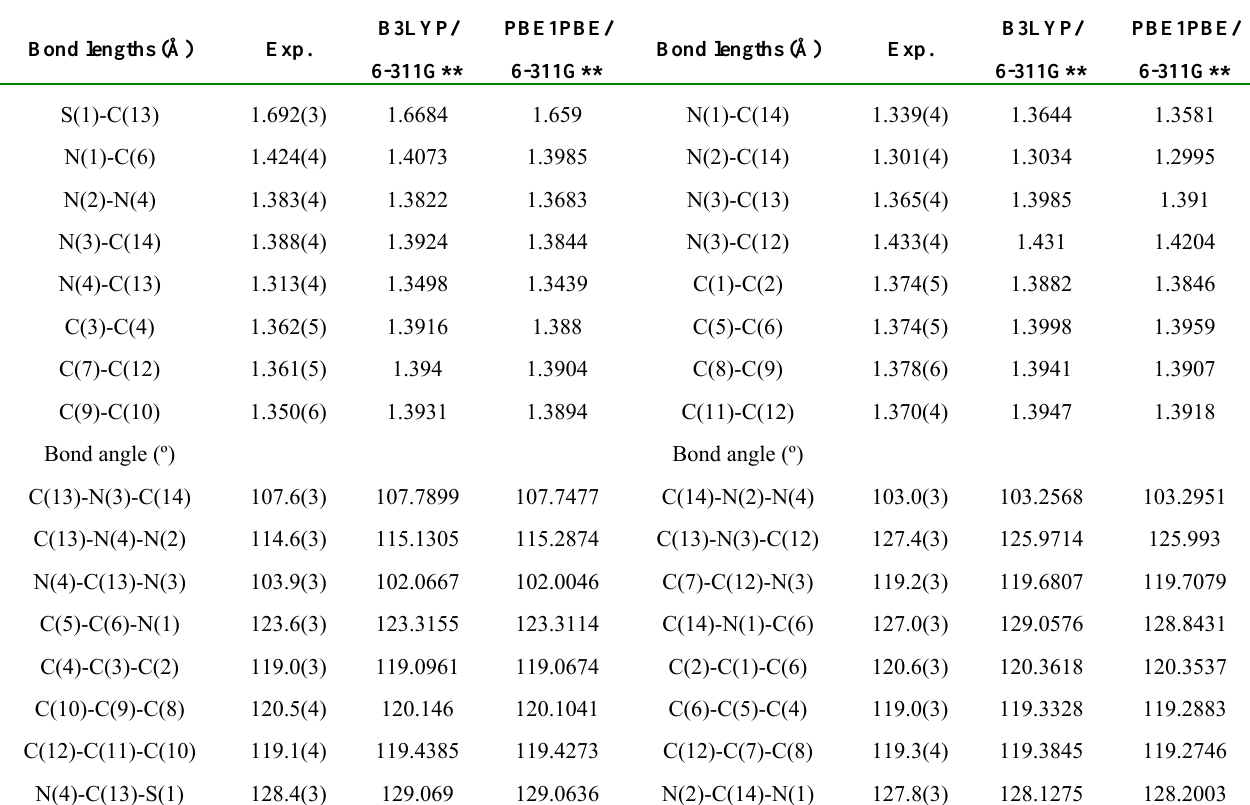
Table 1 . Selected structural parameters by X-ray and theoretical